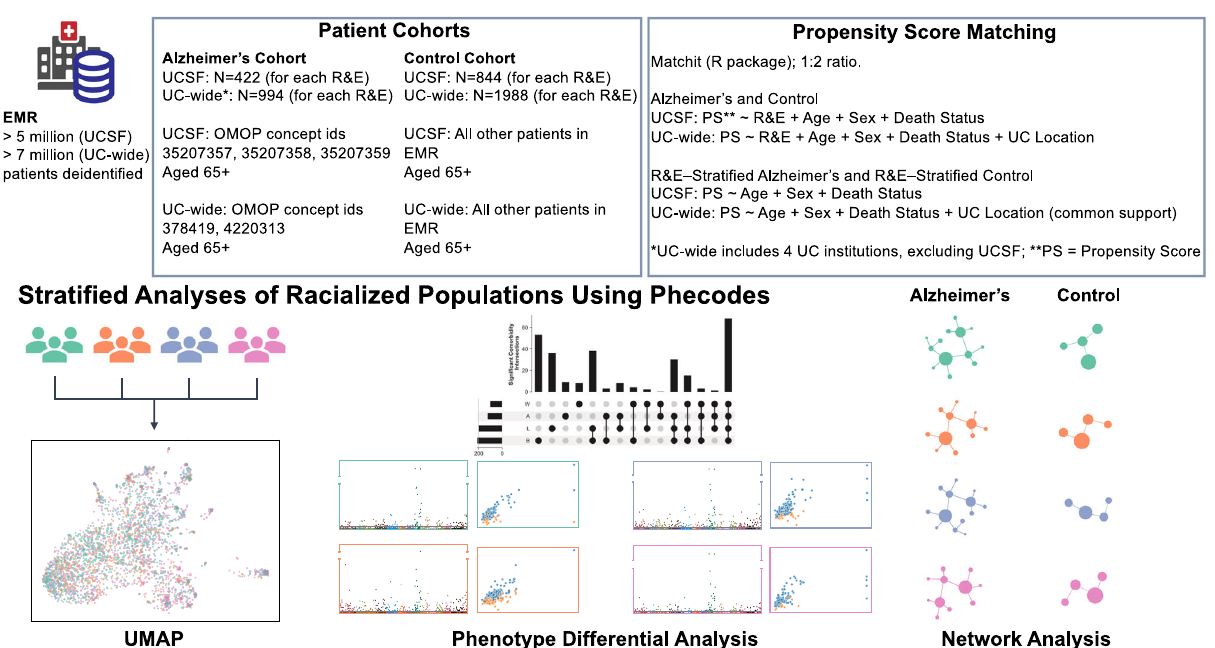
Fig. 1 Visualization of analysis and methods. This provides an overview of patient selection for UCSF and the UC-wide validation cohort, as well as the analyses performed, which include low-dimensional embedding, differential analysis, and network analysis. EMR Electronic medical records, OMOP Observational Medical Outcomes Partnership, PS Propensity score, R&E Race and ethnicity, UCD University of California Davis, UCI University of California Irvine, UCLA University of California Los Angeles, UCSD University of California San Diego, UCSF University of California San Francisco, UMAP Uniform Manifold Approximation and Projection. Green represents Asian-identi fi ed patients; orange represents Black-identi fi ed patients; purple represents Latine- identi fi ed patients, and pink represents White-identi fi ed patients.